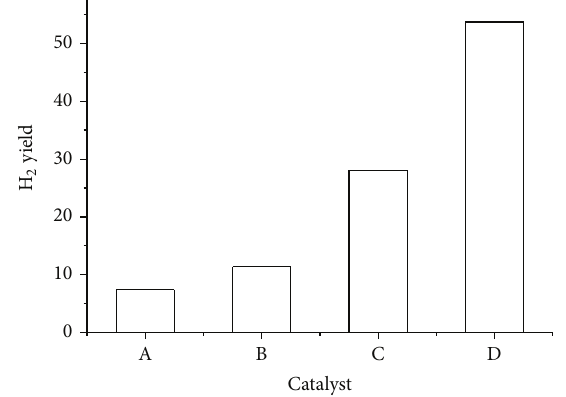
Figure 4: The mixed effect of Raney-Ni and NaOH/g ⋅ kg −1 . Reaction temperature: 400 ∘ C, reaction pressure: 24 ∼ 28 MPa, initial pressure: 4 MPa, residence time: 20 min, and concentration of feedstock: 10% (A: none; B: 0.5 g NaOH; C: 1.0g Raney-Ni; D: 0.5 g NaOH + 1.0 g